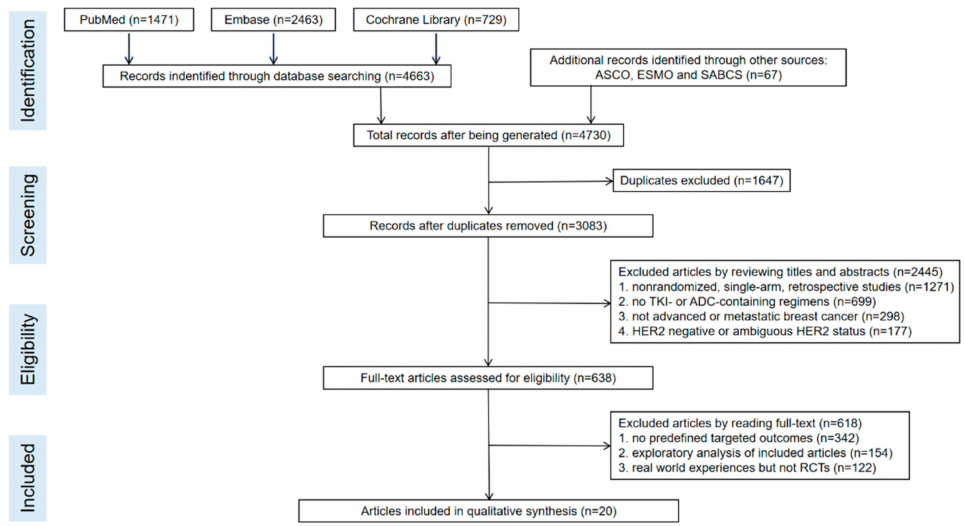
Figure 1. The flow chart of the detailed literature-screening process.